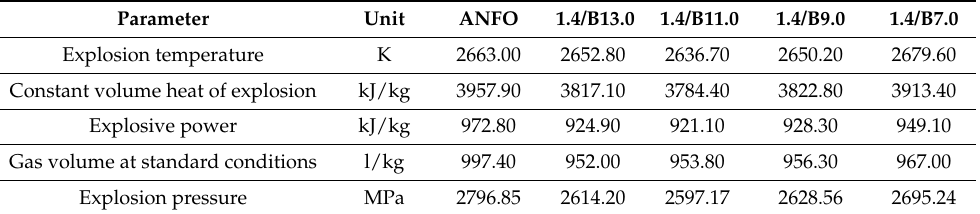
Table 7. Summary of calculated thermodynamic parameters for variant